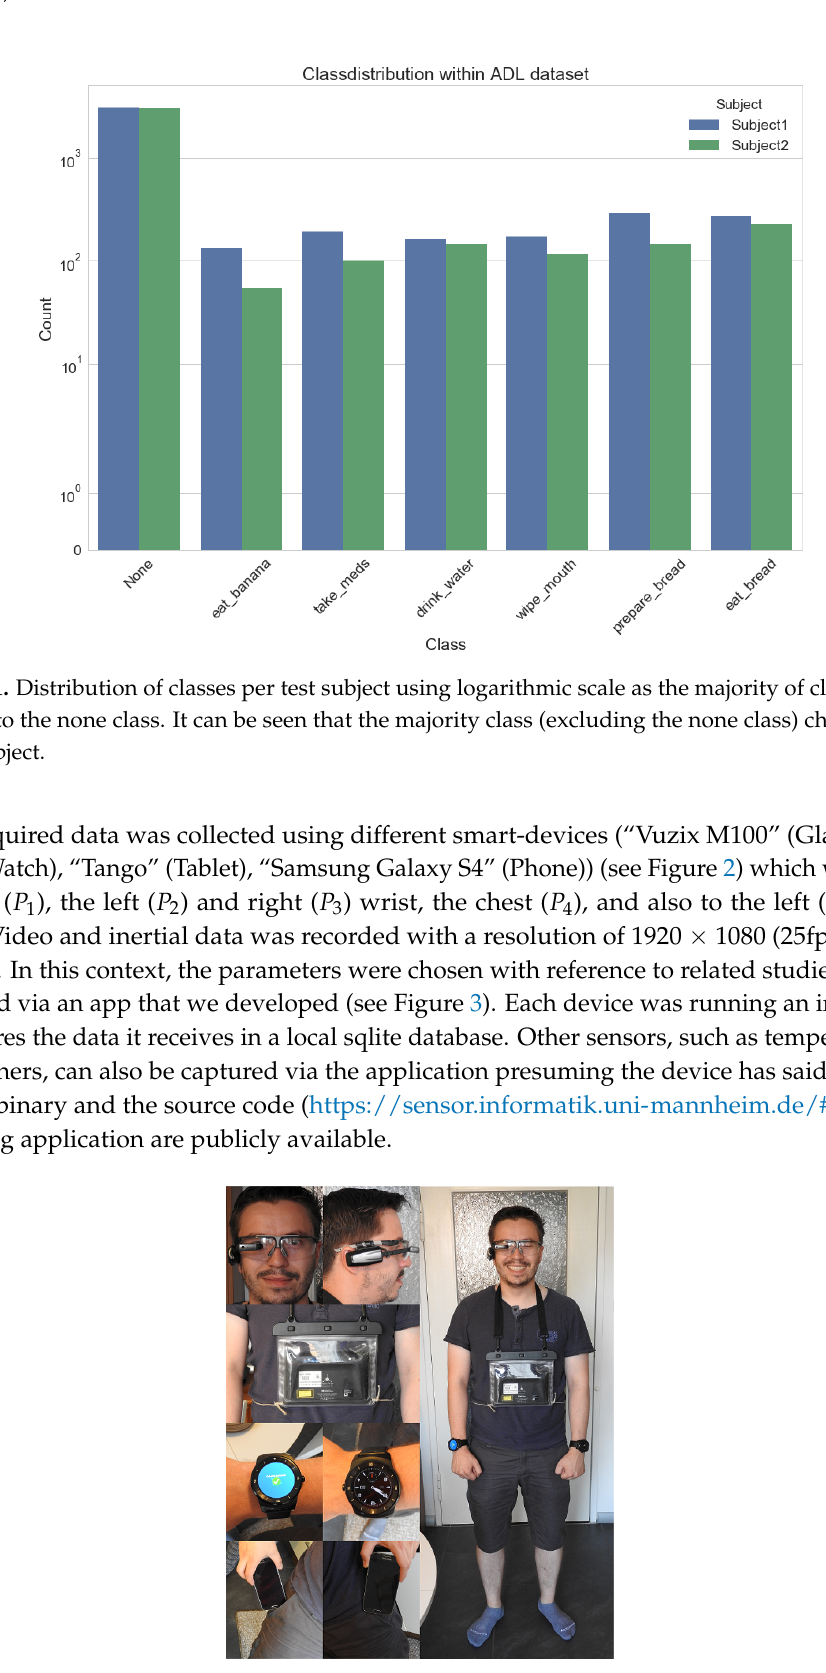
Figure 2. Sensor placement. The subject wears the wearable devices on the head, chest, forearm, and thigh (top